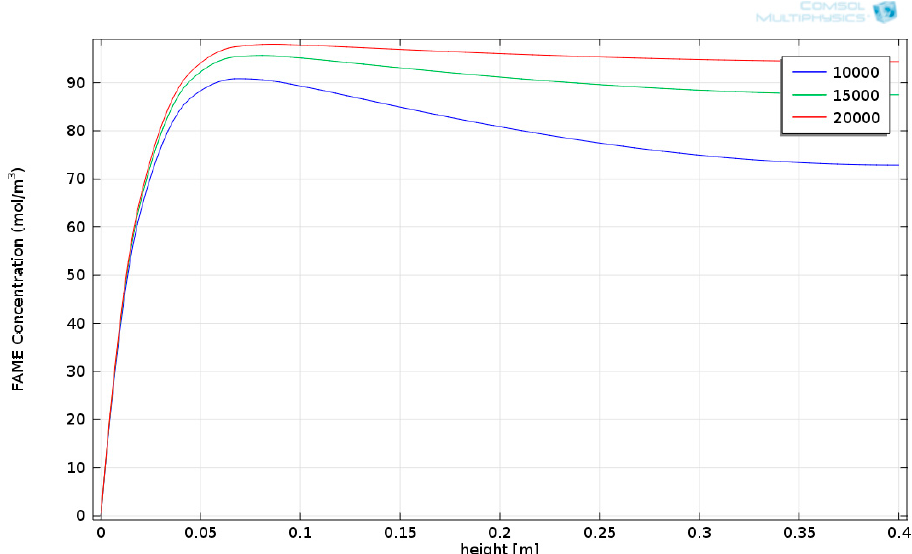
Figure 10. Axial plot of the FAME concentration along the esterification reactor height for phenyl- naphthalene liquid at temperature of 160 °C.